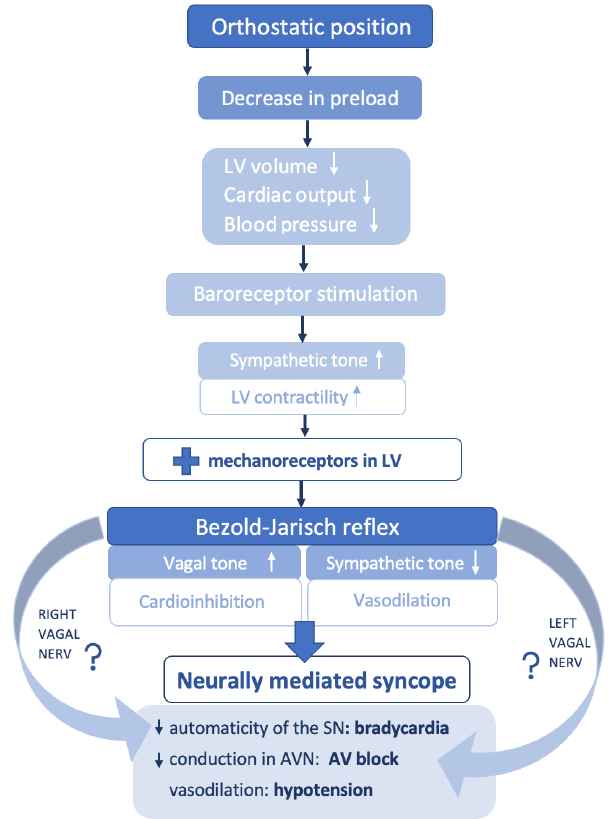
Figure 1. Pathophysiology in neurally mediated syncope. LV = left ventricle, SN = sinus note, AV = atrioventricular, AVN = atrioventricular node.